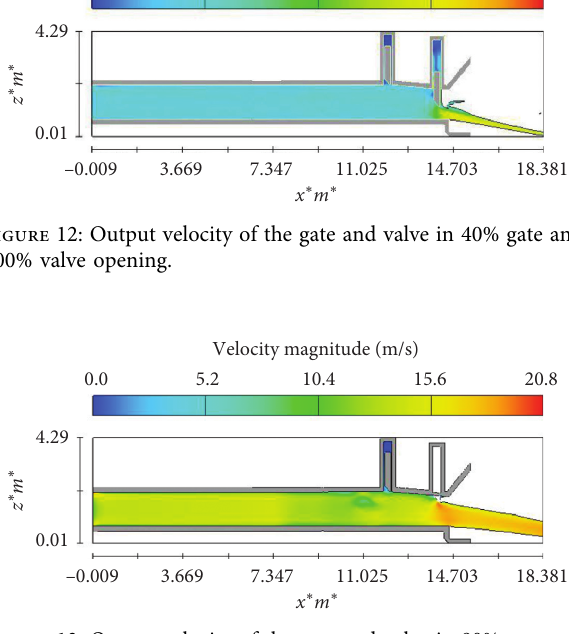
Figure 10: Comparison of analytical solution results and numerical modeling of output flow rate in different gate openings.